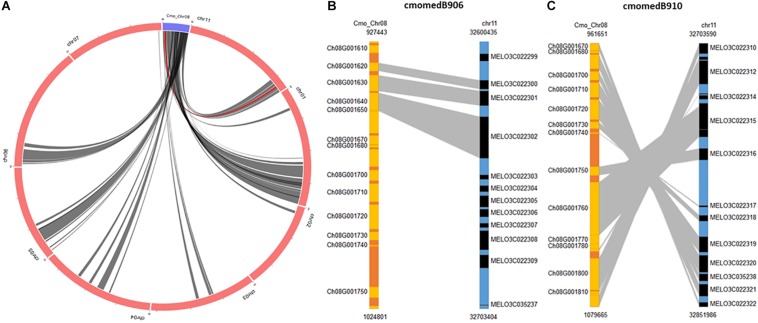
Synteny between the interval regions of quantitative trait loci (QTLs) detected in chromosome 8 of C. moschata and the major QTL in chromosome 11 of C. melo.
(A) Circular representation showing synteny with genome of melon DHL92 (v3.6.1). (B,C) Synteny blocks where QTLs linked to tomato leaf curl New Delhi virus (ToLCNDV) resistance are located (coded as cmomedB906 and cmomedB910 in the database).